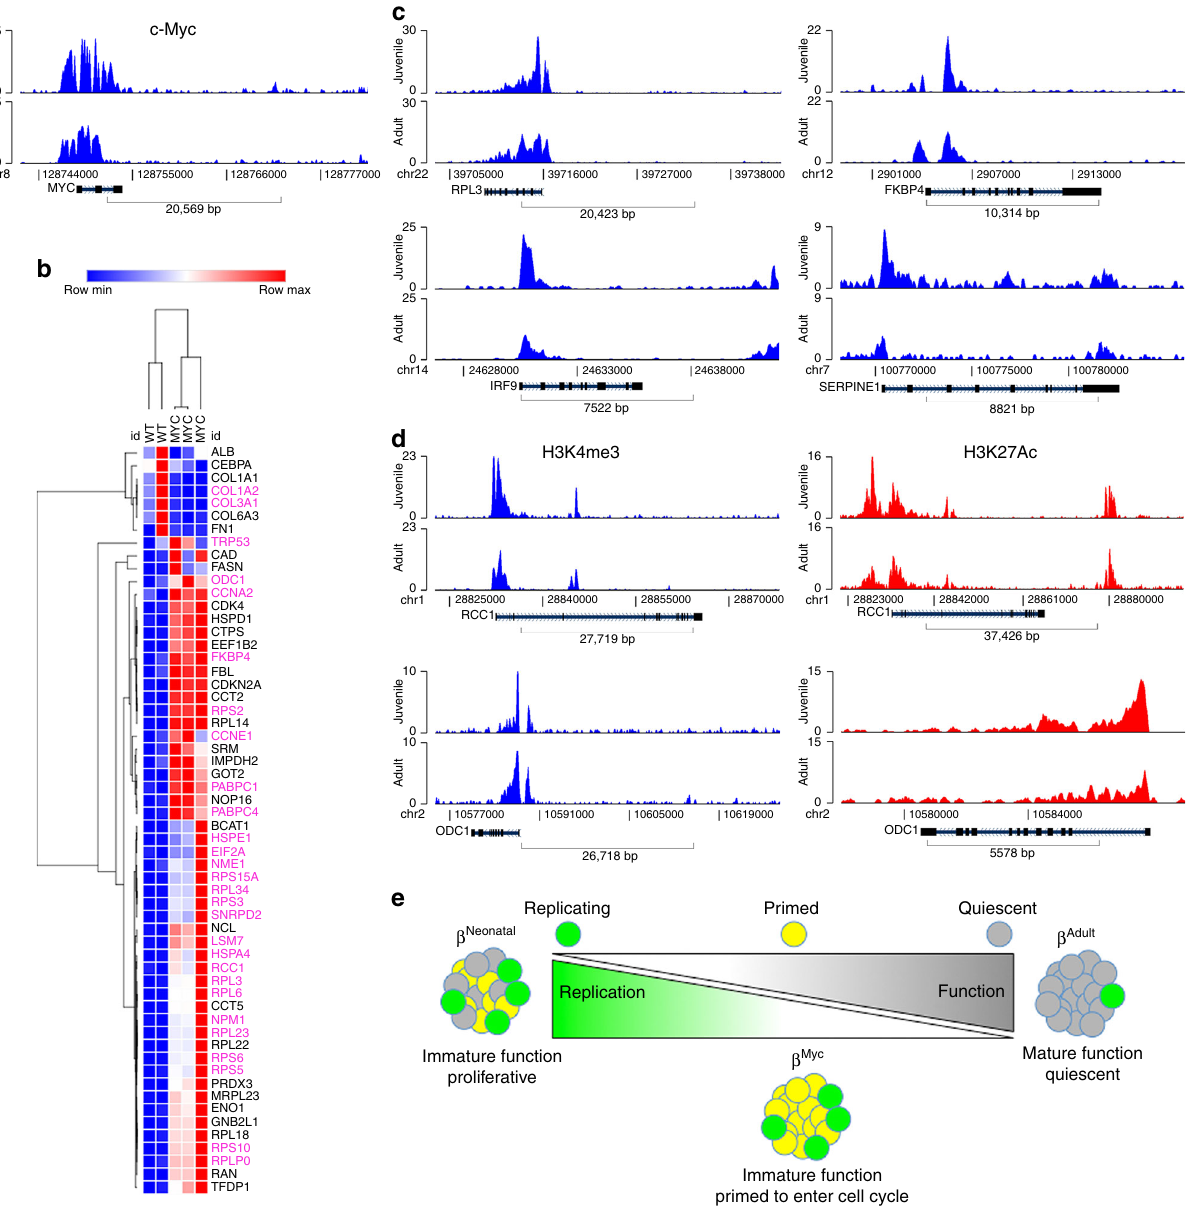
Fig. 6 Analysis of human ChIP data reveals activated marks on c-Myc targets in juvenile samples. a H3K4Me3 ChIP-peak distribution across the c-Myc promoter in β cells isolated from a juvenile (5 years) and an adult (48 years) donor. b RNA-seq data demonstrating levels of several c-Myc targets in islets from Ins-c-Myc and control animals. Genes marked in purple show differential H3K4 trimethylation marks in the juvenile donor samples as compared to the adult sample. c H3K4Me3 ChIP-peak distribution in RPL3 , IRF9 , FKBP4 , and SERPINE1 genes in a juvenile (5 years) and adult (48 years) sample. d H3K4Me3 and HeK27Ac marks in the juvenile (5 years and 0.8 years respectively) samples as compared to the adult (48 years and 66 years respectively) samples of c-Myc target genes RCC1 and ODC1 . e Schematic representing a key role of c-Myc is the early stages of life, at a time of increased proliferation and immature function within β cells. With age, a reduction in c-Myc occurs concomitant with acquisition of maturation features and loss of replicative capacity. In the Ins-c-Myc animals, β cells continue to express c-Myc well into adulthood and throughout life, leading to a persistence of replicative capacity, and a failure of the cells to undergo maturation, thus leading to dysregulated glucose